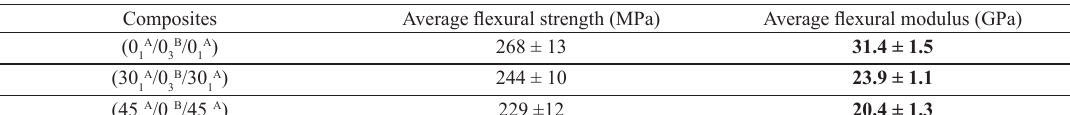
Table 4. Flexural test results of hybrid composites.